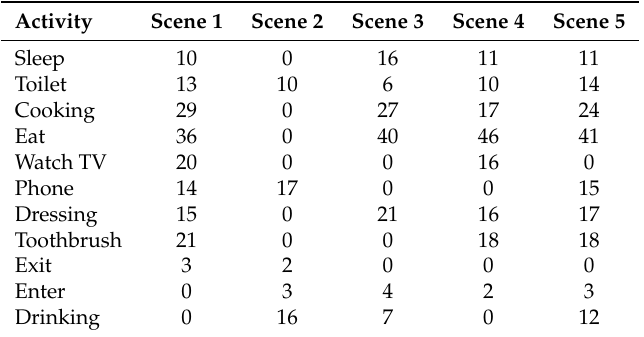
Table 2. Frequency (number of time-steps) for each activity and